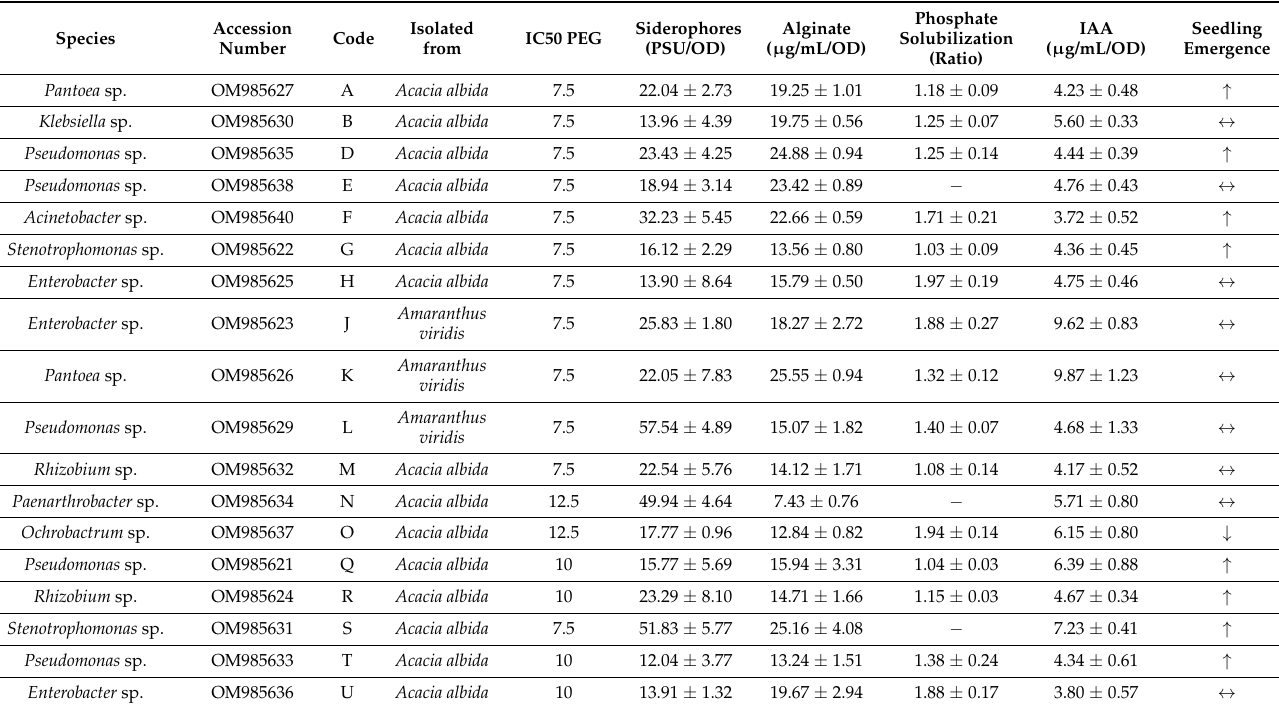
Table 1. Identification and plant growth-promoting abilities of bacteria isolated from Cape Verde. Determination of the percentage of polyethylene glycol that inhibits 50% of bacterial growth (IC50 PEG). Indole acetic acid (IAA) and alginate production were expressed in µ g/mL/DO. Siderophore production was expressed in percent siderophore units per optical density (PSU/DO). Phosphate solubilization was expressed by the ratio between halo and colony diameter. The plant emergence rate was determined in the 4th day of growth, in comparison with not-inoculated control ( ↑ — increase, ↓ —decrease, ↔ —no